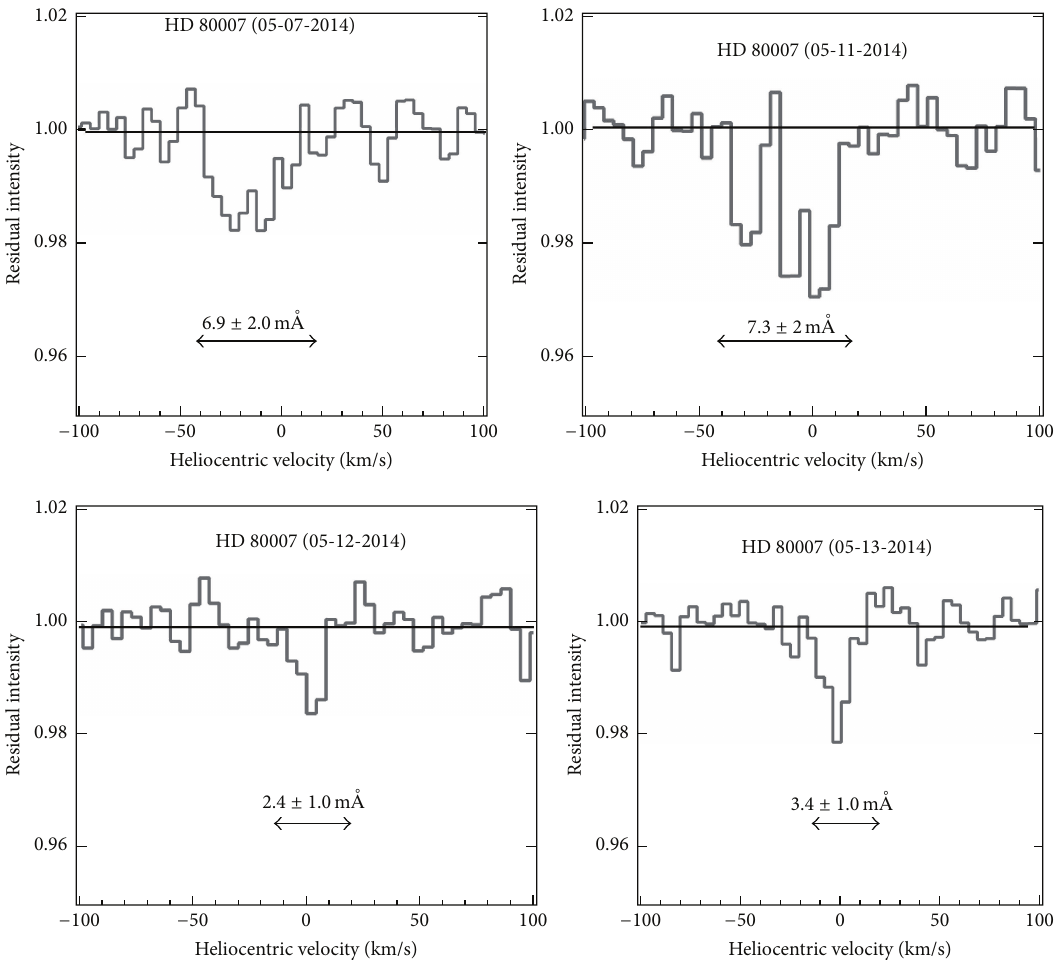
Figure 6: Circumstellar CaII K-line absorption spectra of the star HD 80007 recorded at SAAO over the period 05-07-2014 to 05-13-2014.